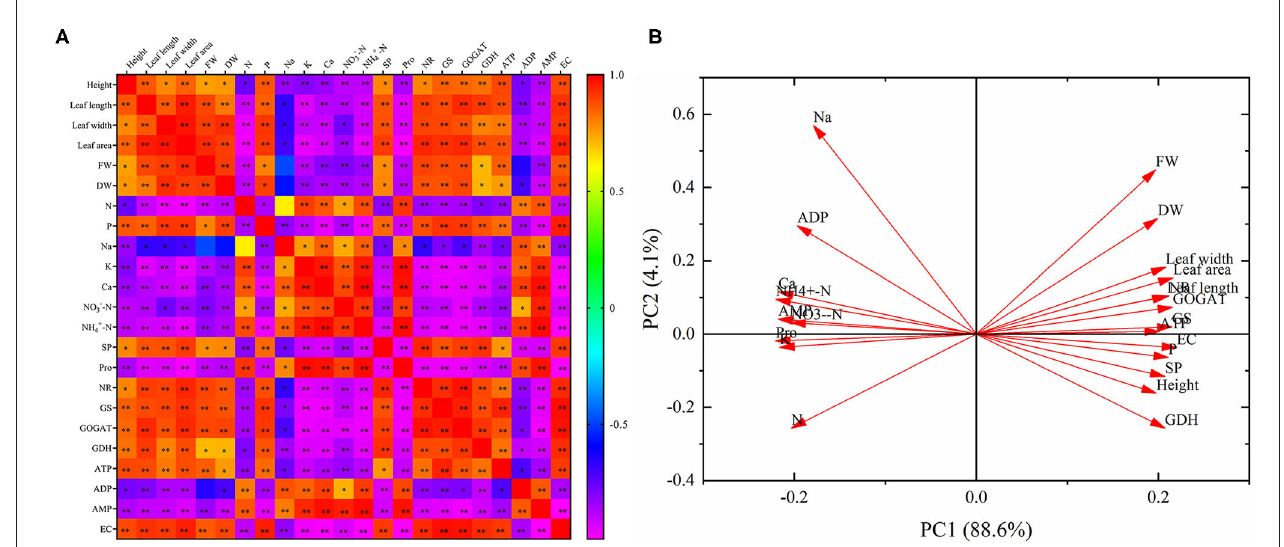
FIGURE 7 | Correlation analysis (A) and principal component analysis (B)